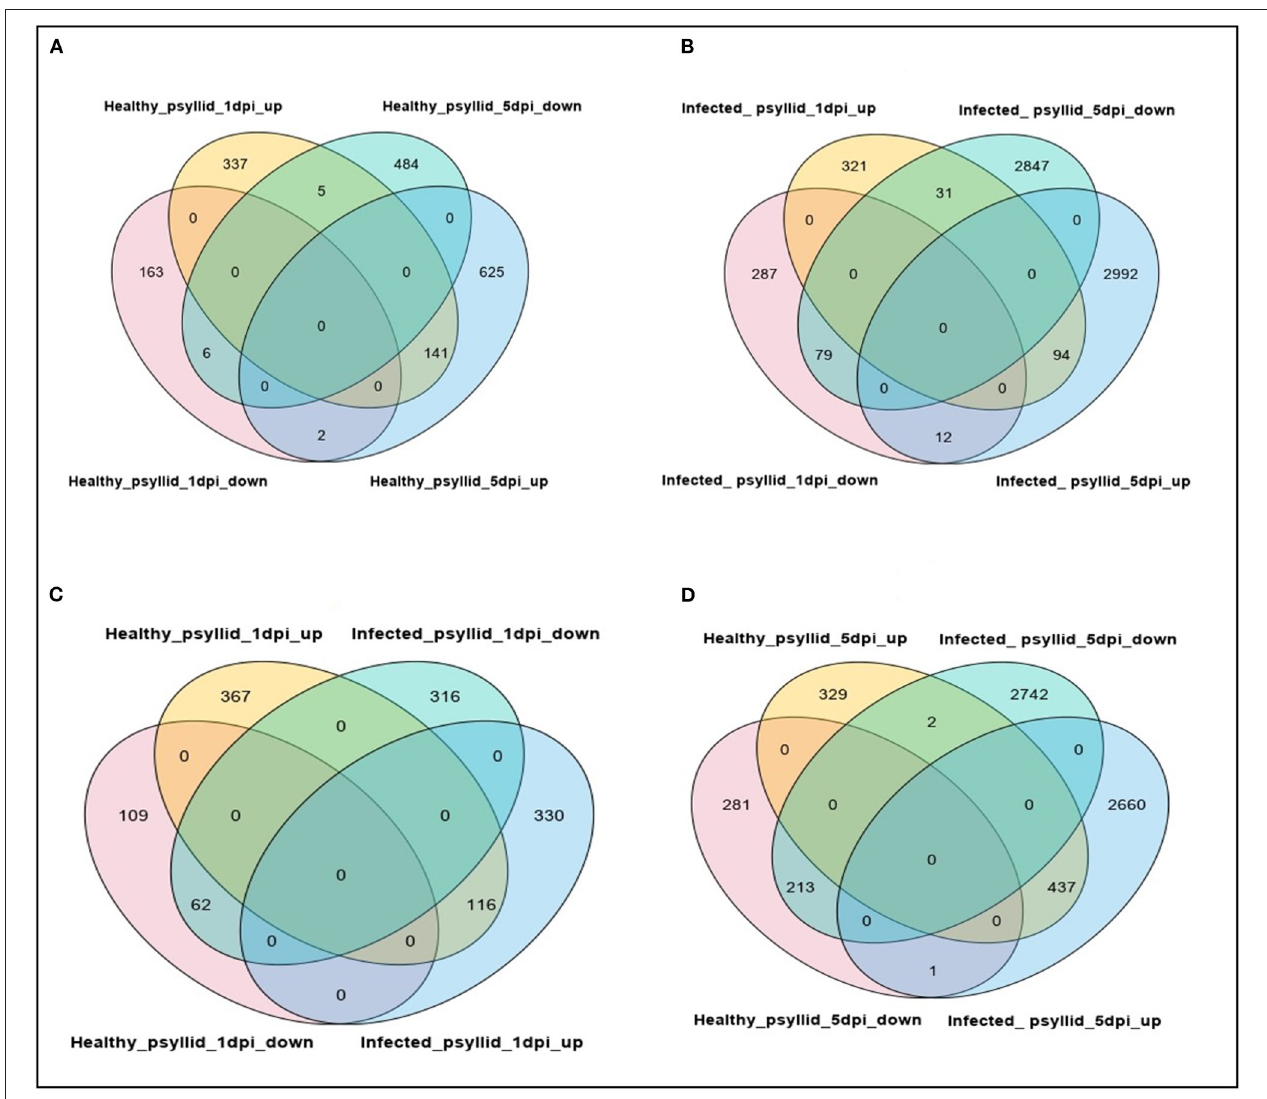
FIGURE 2 | Venn diagrams showing numbers of upregulated and downregulated DEGs after healthy and Ca Las-infected psyllid attacks in Valencia sweet orange, at different time points post-infestation. (A) Healthy_psyllid_at 1 dpi vs. healthy_psyllid at 5 dpi; (B) Infected_psyllid_at 1 dpi vs. Infected_psyllid_at 5 dpi; (C) Healthy_psyllid_at 1 dpi vs. infected_psyllid_at dpi; (D) Healthy_psyllid_at 5 dpi vs. Infected_psyllid_at 5